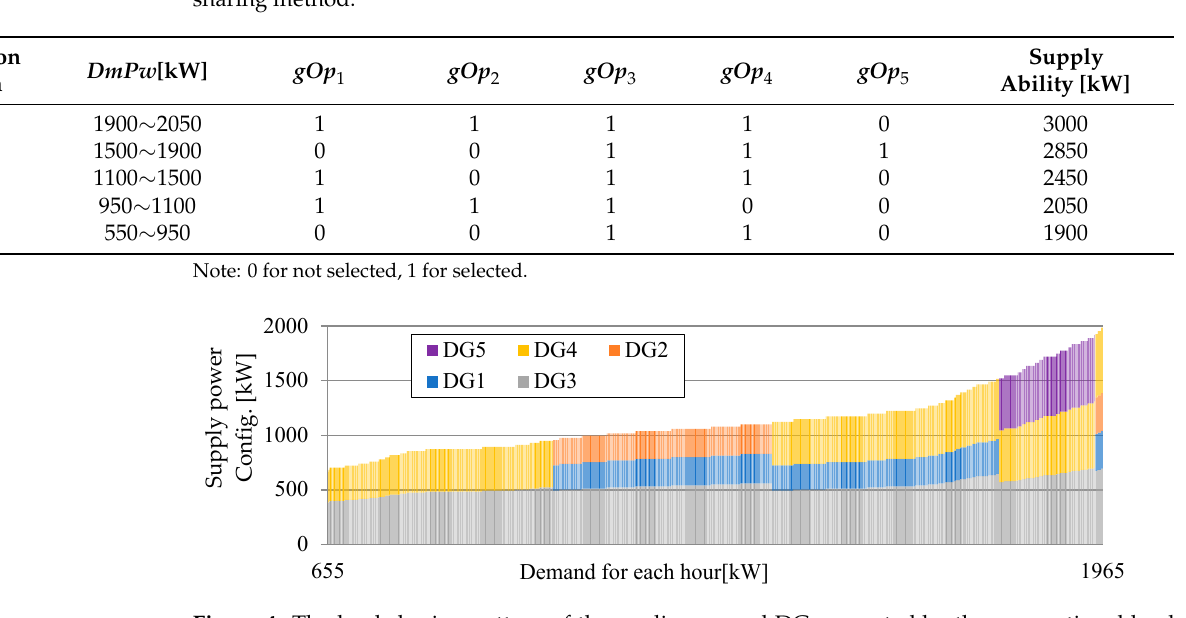
Figure 4. The load sharing pattern of the medium-speed DGs operated by the conventional load sharing method. Table 6. The operation configuration of the five units of medium-speed DGs operated by the conventional load sharing method.